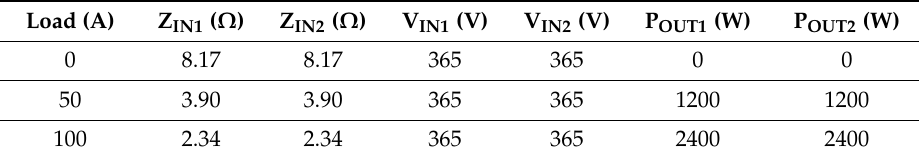
Table 2. Input balance characteristic of the proposed